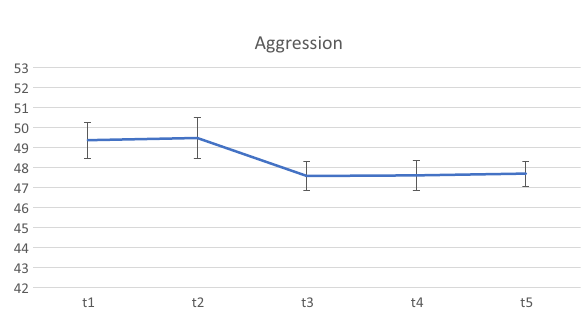
Figure 2. BASC-2 aggression scores from Waitist to 6 month follow-up.